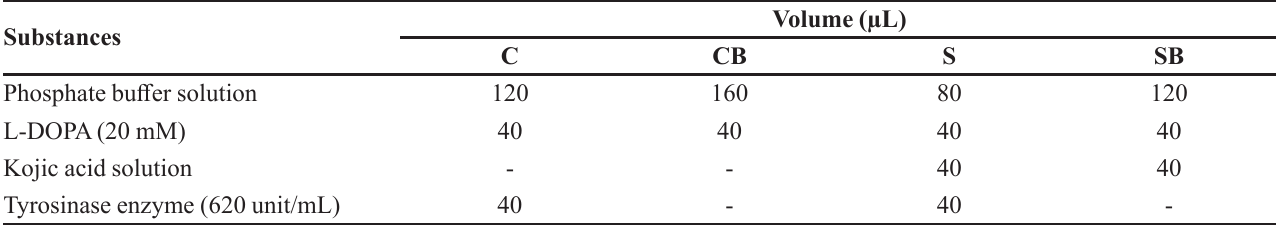
C = Control, CB = Control-Blank, S = Sample, SB = Sample-Blank TABLE II - Substance composition ot tyrosinase inhibitory activity of IL-MAE extract Substances